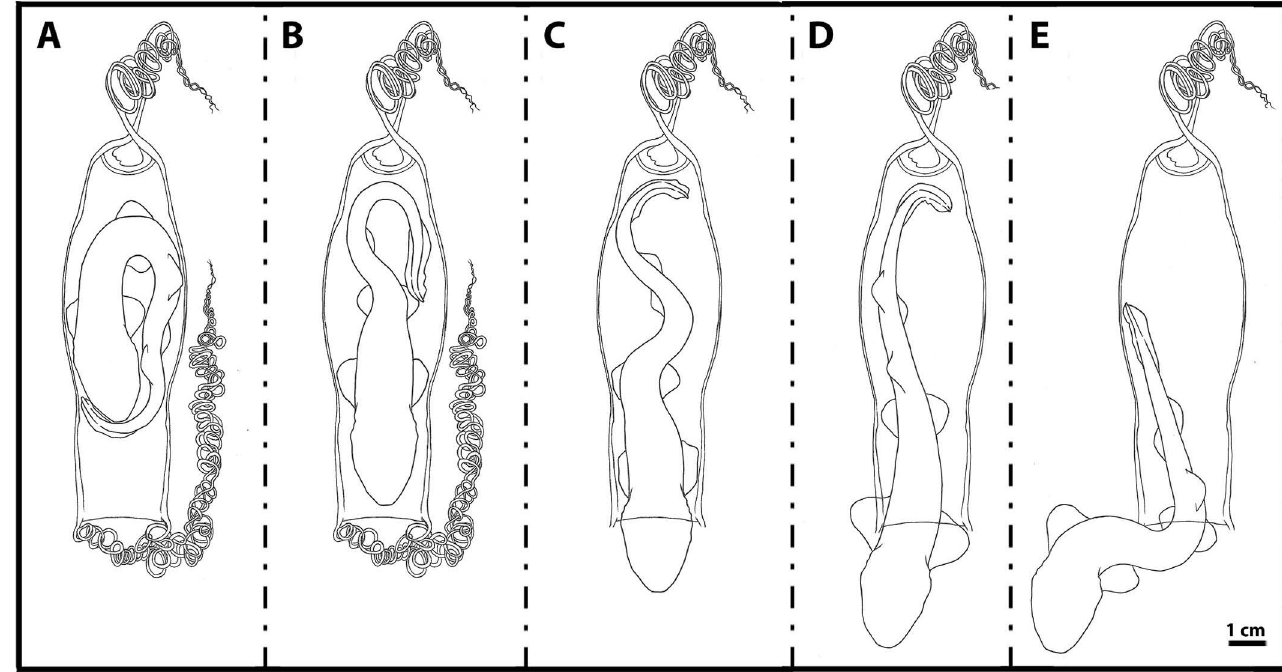
Fig 14. The hatching process. A: Embryo with curled body inside the egg case. B: Embryo facing the flat end of the egg case. C: Embryo tail pushed against arched wall of the egg case. D: Embryo pushed its body through the flat end of the egg case. E: Embryo swam out of the egg case.